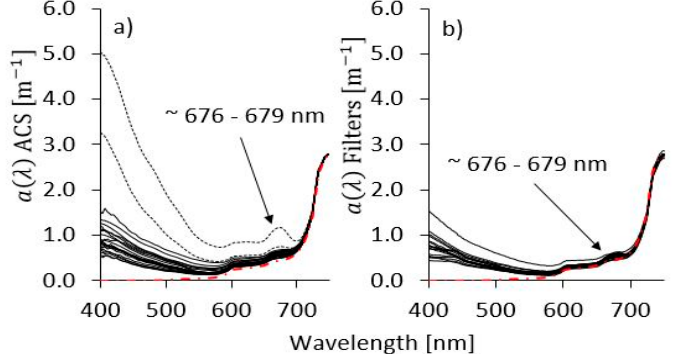
Figure 7. Field 𝑎(λ) values for: ( a ) 2013; and, ( b ) 2019.